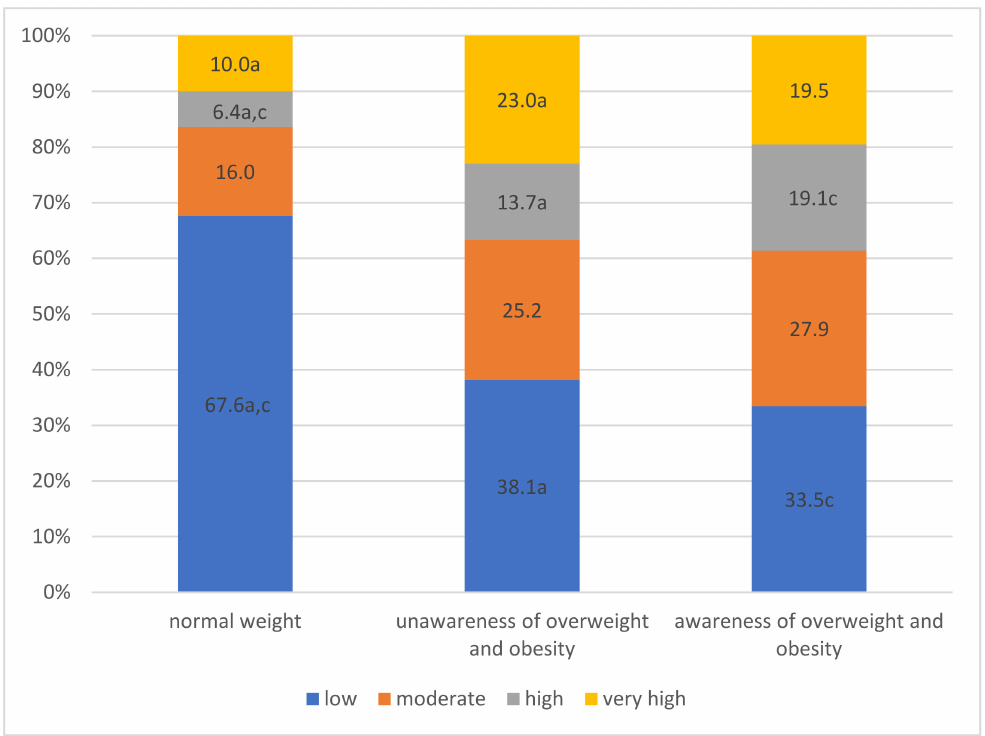
Figure 4. Schematic presentation of cardiovascular risk classes in the study population: (a) significant difference between group with normal weight and group unaware of overweight and obesity; (c) significant difference between group normal weight and group aware of their overweight and